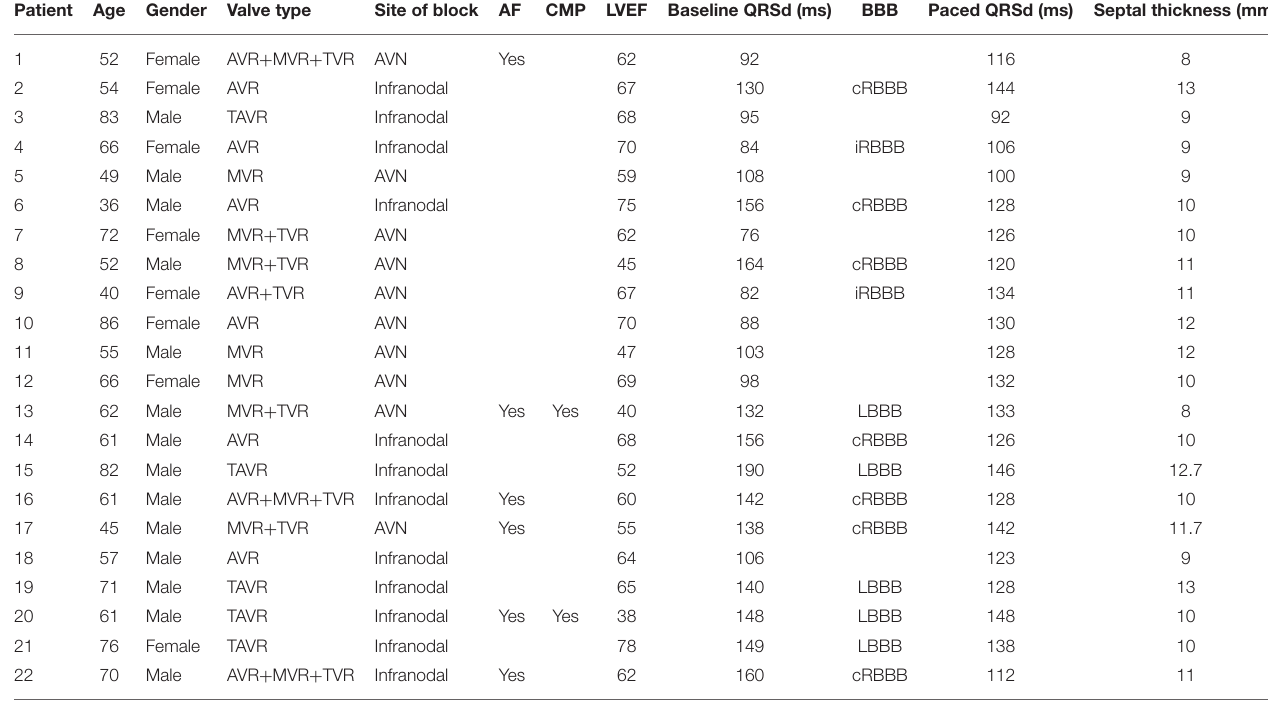
TABLE 1 | Baseline characteristics and procedural results. Patient Age Gender Valve